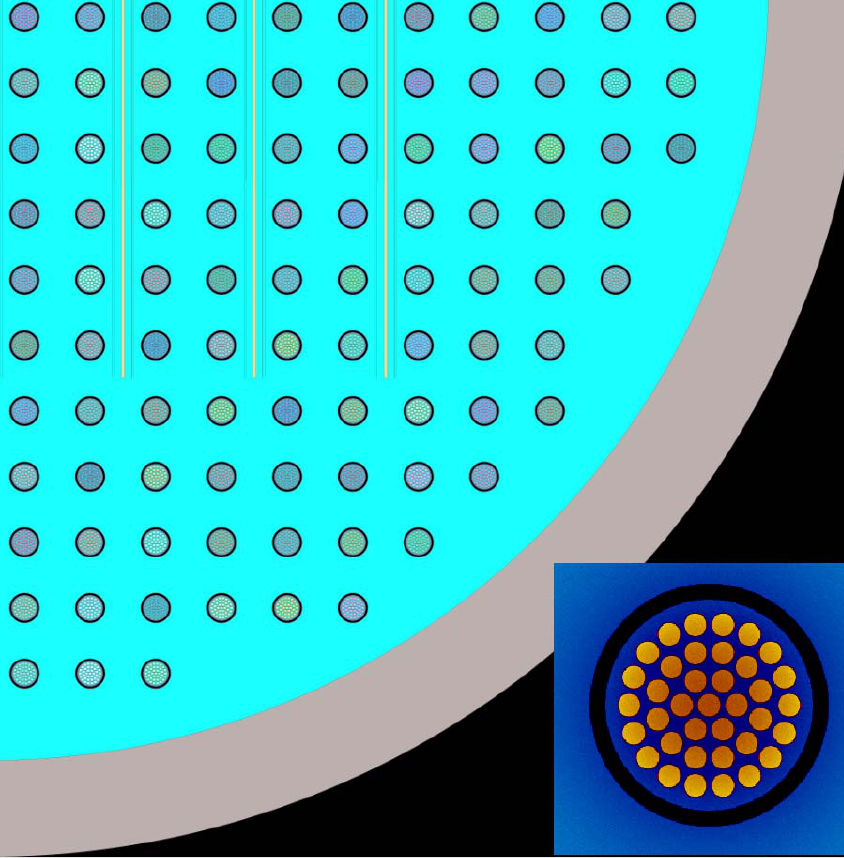
Figure 1: Illustration of the Quarter-Core CANDU-6 Model Depicting Core Geometry and Bundle Geometry from an Axial Slice